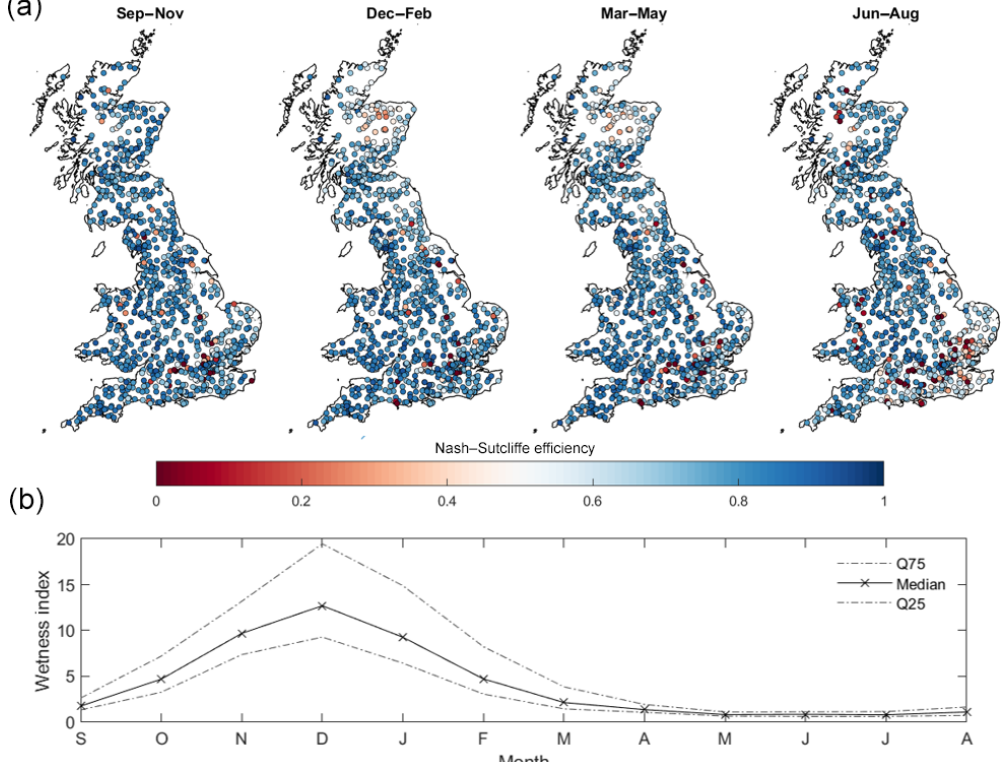
Figure 7. GB maps of FUSE multi-model ensemble model performance for each season (a) and observed seasonal variations in catchment wetness index (b) . Each point in (a) is a gauge location which is coloured based on the best Nash–Sutcliffe score attained by any of the four models sampled for that catchment and season. (b) then shows how seasons vary hydrologically across GB, through the wetness index (precipitation/PET or precipitation divided by PET) calculated from the observed data, split by month, used to drive the hydrological models across all catchments shown in (a)